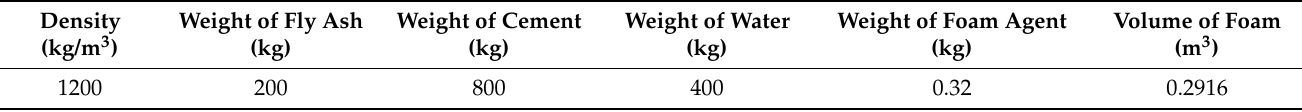
Table 1. Mix ratio of foam concrete of 1200 kg/m 3 density.